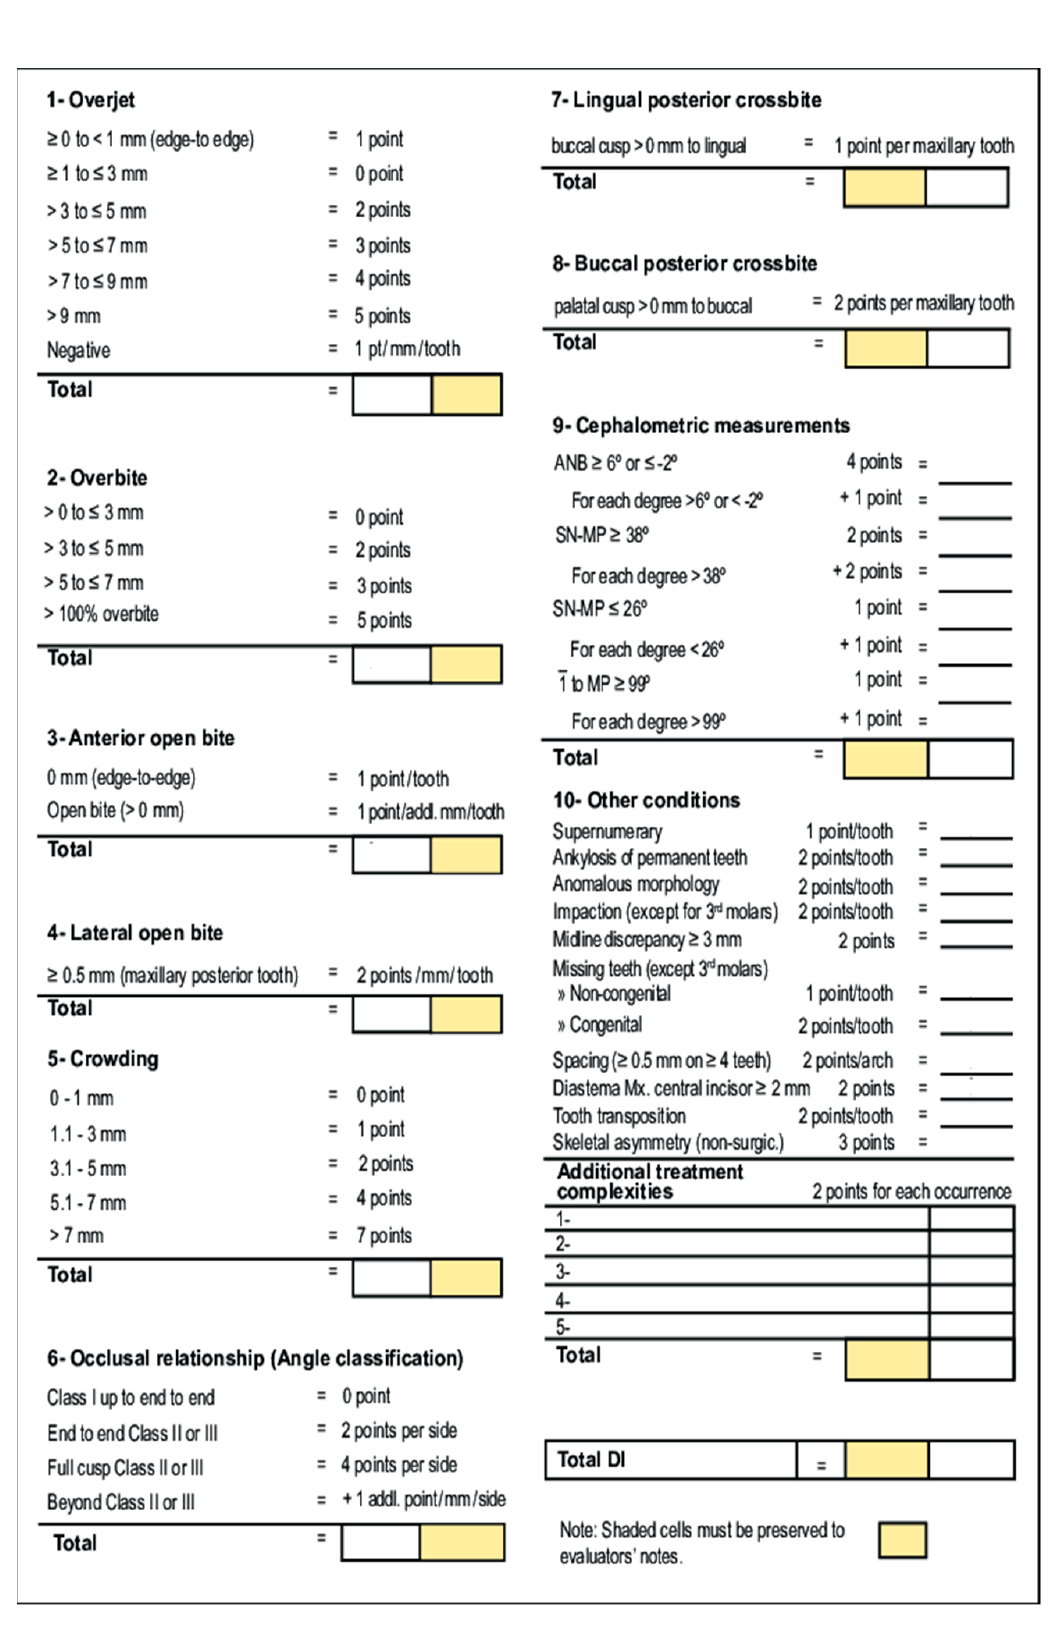
Figure 1. ABO Discrepancy Index [23]. American Board of Orthodontics (ABO); Analysis of the intermaxillary relationship (ANB); Sella Nasion and mandibular plane (SN-MP)